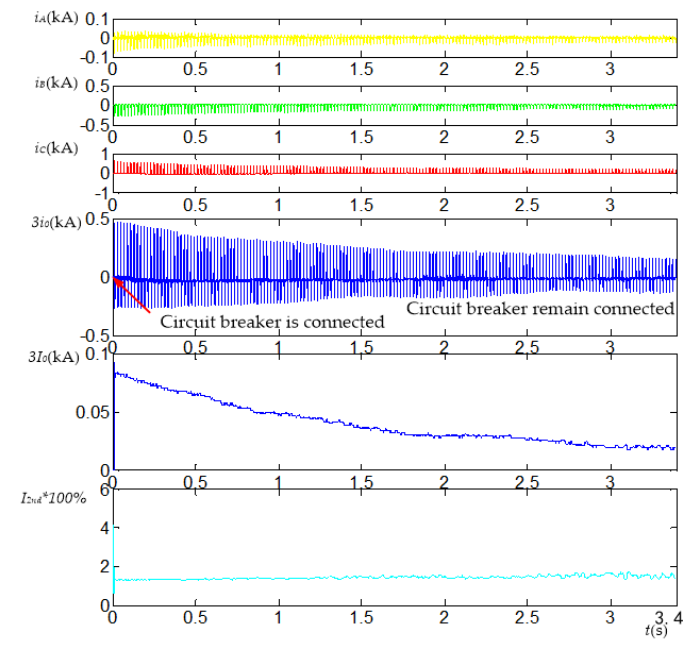
Figure A1. Recorded waveform Number One (0 – 3.4 s).